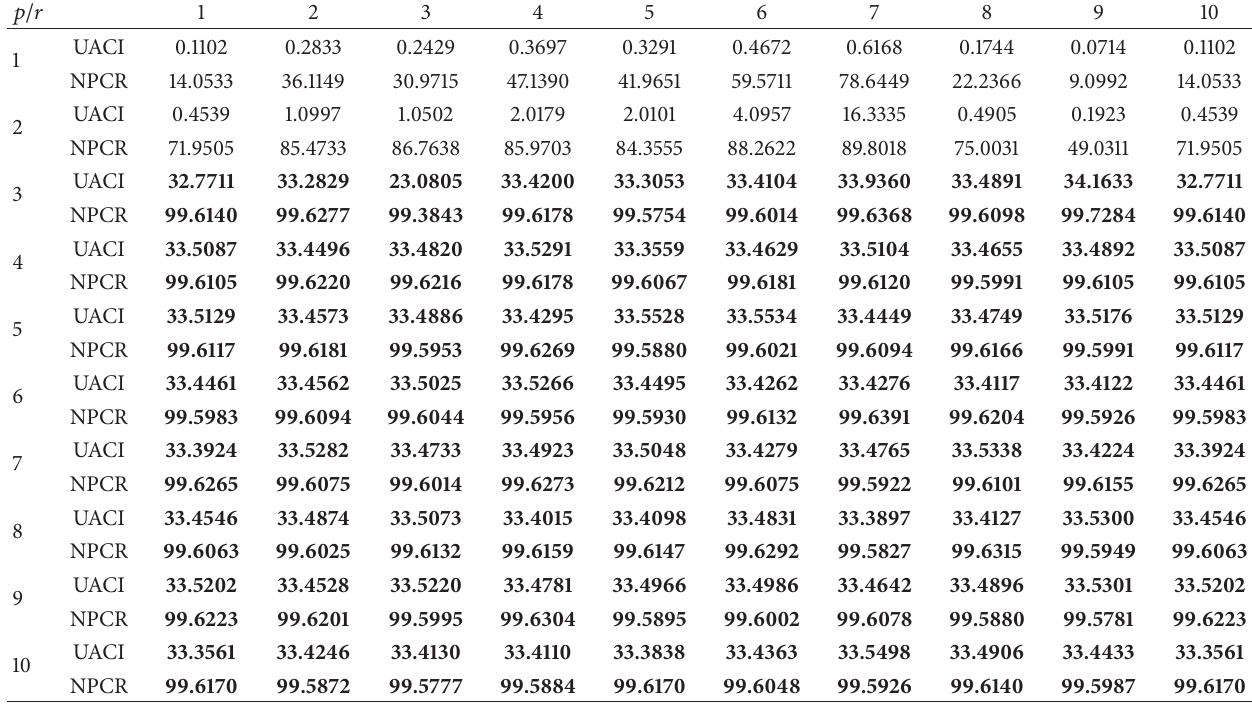
Table 12: Calculated UACI and NPCR for different combinations of 𝑝 and 𝑟 while 𝑞 = 1 in Fingerprint.